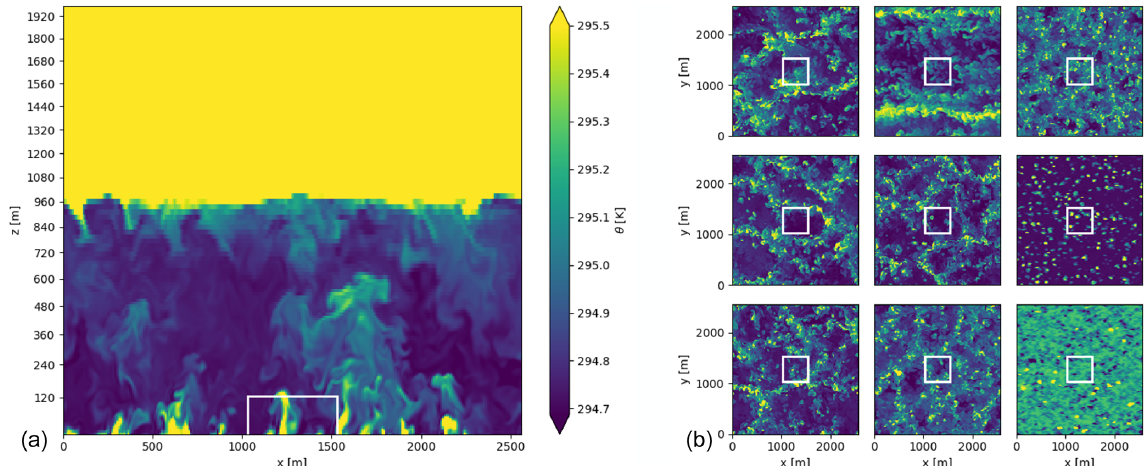
Figure 1. (a) Instantaneous potential temperature θ in the x – z cross section at the center of the domain for the truth run at 1h simulation time. The vertical axis is scaled with a power law function for better visibility of the boundary layer. (b) Instantaneous potential temperature x – y cross section at 100m height for the truth run (lower left panel) and eight typical ensemble members at 1h simulation time. The color scale is independent for each ensemble member and omitted for clarity, since we would like to emphasize relative differences in the spatial structure of the turbulent fields. In all plots, the white box indicates the domain for possible drone